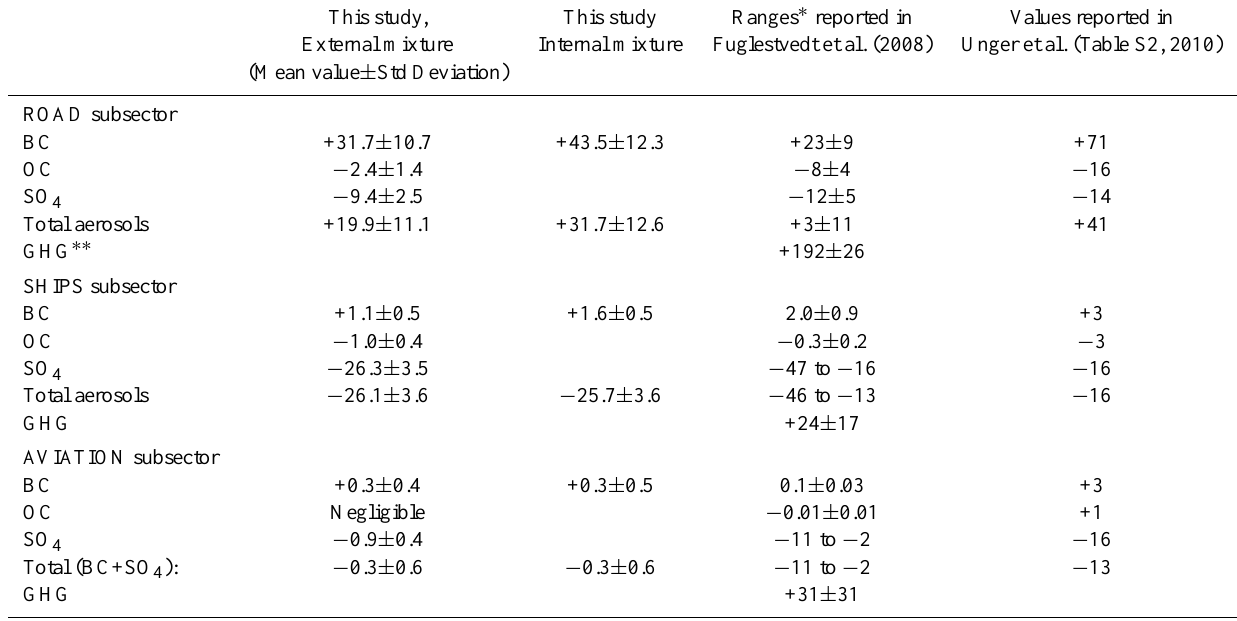
Table 4. Mean direct radiative forcings and standard deviation (mWm − 2 ) computed in this study together with the values reported by Fuglestvedt et al. (2008) associated with estimated uncertainties. This study, This study Ranges ∗ reported in Values reported in External mixture Internal mixture Fuglestvedt et al. (2008) Unger et al. (Table S2, 2010) (Mean value ± Std Deviation) +43.5 ± 12.3 +23 ±